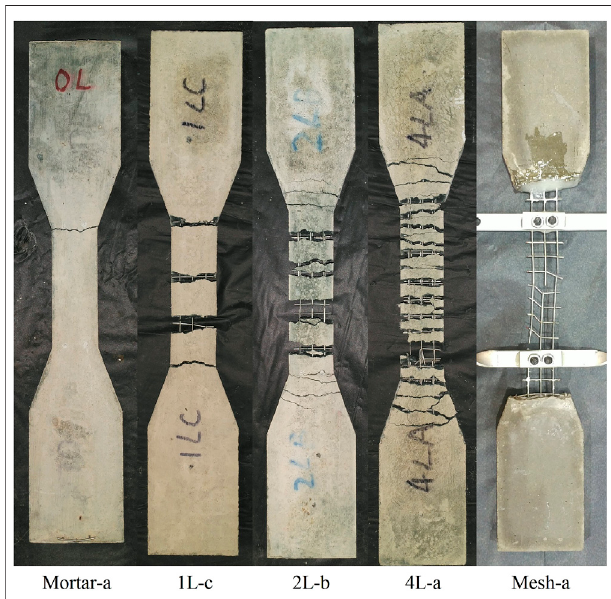
FIGURE 4 | Failure modes of specimens under direct